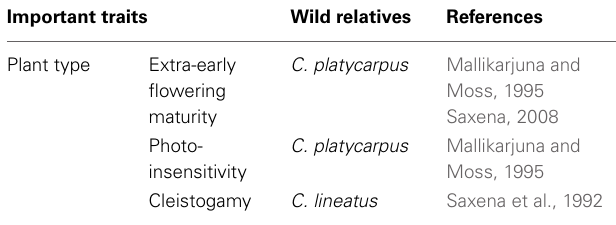
Table 1 | Different wild species of pigeonpea useful for rendering valuable